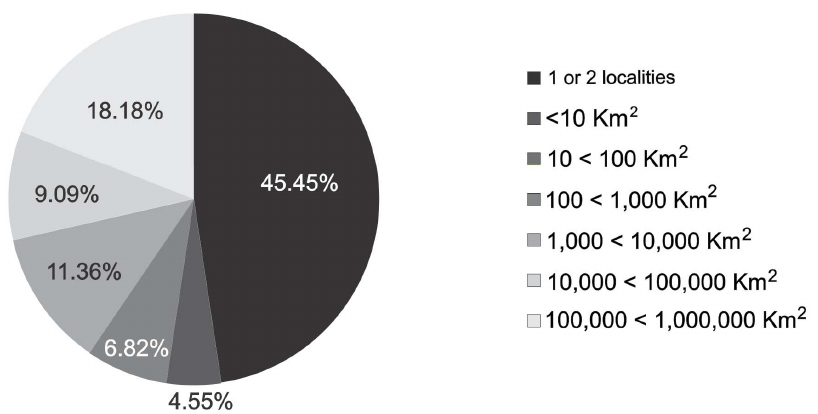
Figure 4. Comparative range size of lineages. Range size of lineages within the Dendropsophus minutus complex. Most lineages appear to be microendemic and are only recorded from one or two localities while eight lineages have ranges larger than 100,000 km 2 .